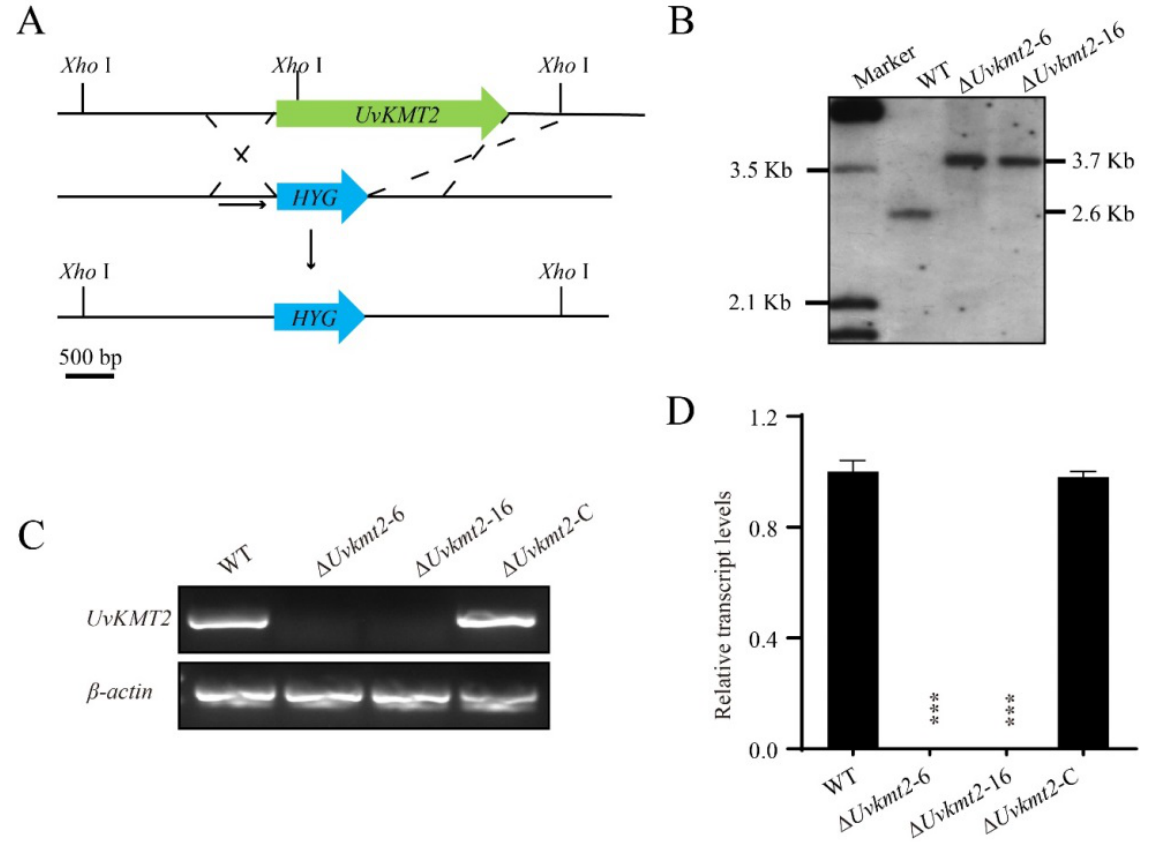
Figure 2. Disruption of UvKMT2 and complementation analysis. ( A ) Strategic map of UvKMT2 gene disruption and sites for restriction enzyme Xho I. HYG , hygromycin resistance gene cassette . Scale bar = 500 bp. ( B ) Southern blot analysis verified the correct UvKMT2 deletion mutants. Genomic DNA of indicated strains was extracted and digested by Xho I. The probe for Southern blotting locates downstream of the UvKMT2 coding region, as shown by the arrow line in ( A ). In the correct UvKMT2 deletion mutants, a 2.6 Kb band in the HWD-2 was shifted to 3.7 Kb. Verification of UvKMT2 deletion mutants and complementation strain was carried out by RT-PCR ( C ) and qRT-PCR ( D ) analyses. Obvious UvKMT2 expression was detected in the WT and Δ Uvkmt2 -C strains but not in the Δ Uvkmt2 - 6 and Δ Uvkmt2 -16 mutants. Similar results were obtained from three biological repeats. Asterisks represent significant difference at p value < 0.001.